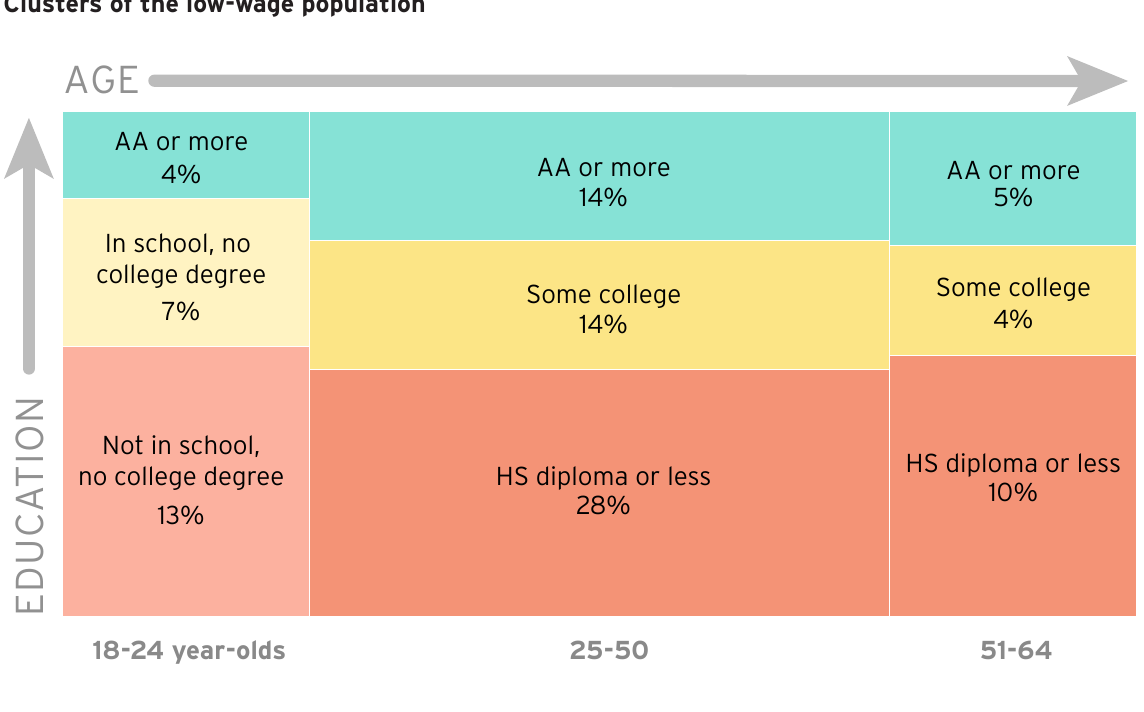
Source: Brookings analysis of 2012-2016 American Community Survey 5-year Public Use Microdata